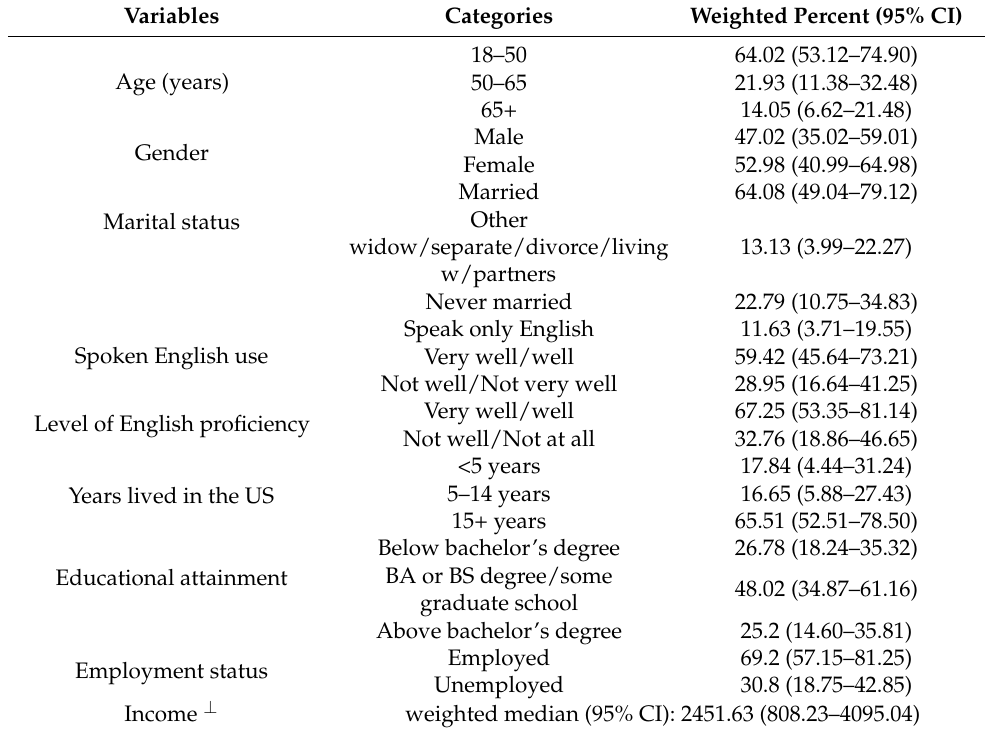
Table 1. Demographic variables ( n =